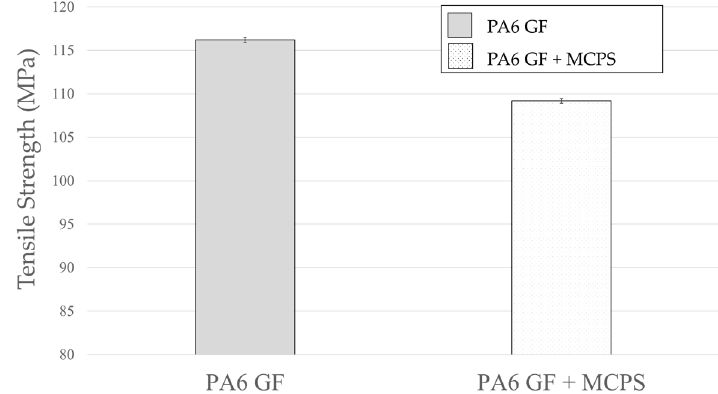
Figure 18. Effect of MCPs on tensile strength.